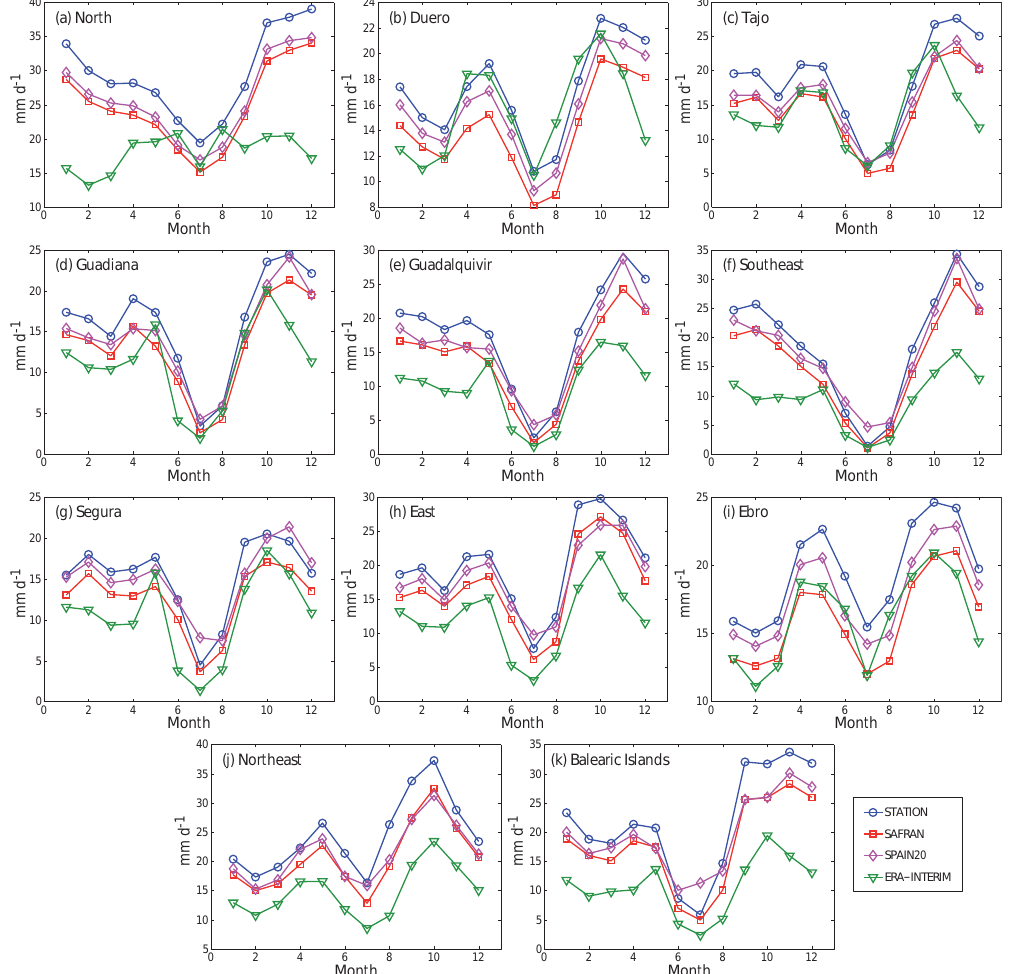
Figure 4. The annual cycle of maximum precipitation in 1 day (RX1D) for the Spanish river basins. The y axis range is different for each figure to highlight the differences between the